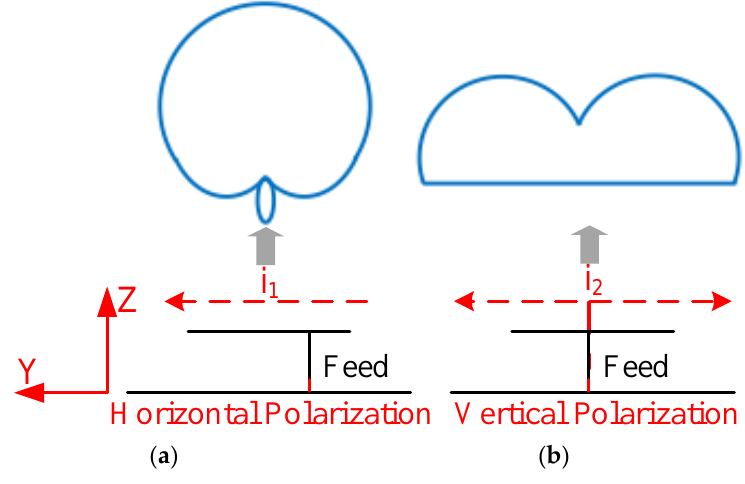
Figure 2. Radiation modes. ( a ) Patch mode. ( b ) Monopole mode.